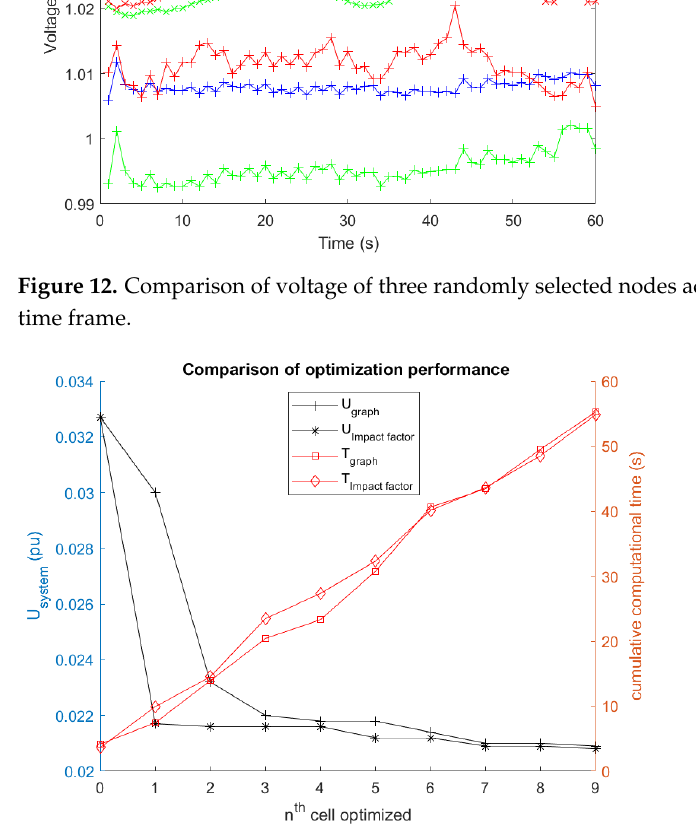
Figure 13. Comparison of optimization performance. Here, T graph and T impactfactor represents the cumulative time for each iteration, where time is given in the right y -axis, and the U graph and U Impact gives the utility value for each iteration, where utility is shown in the left y f actor